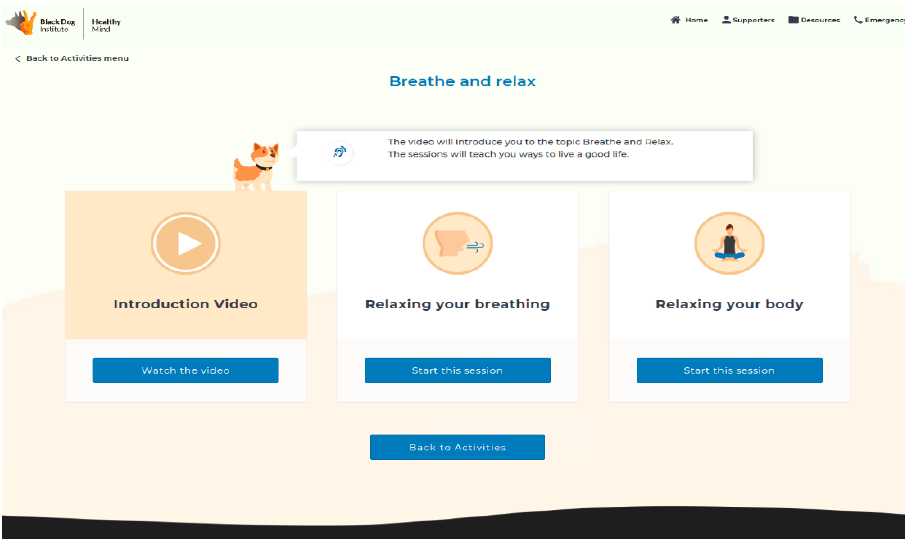
Figure 2. Screenshot of Healthy Mind dashboard.